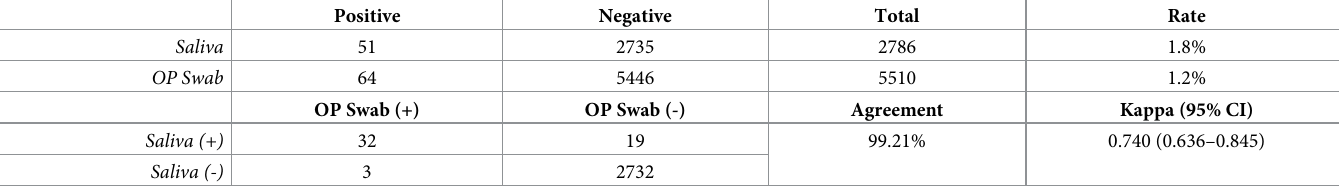
Table 1. Pooled saliva testing validation